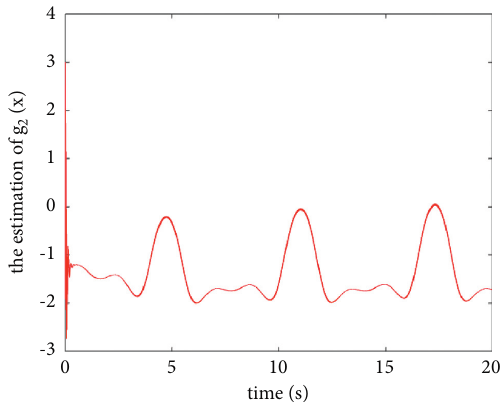
Figure 12: The approximate process of g